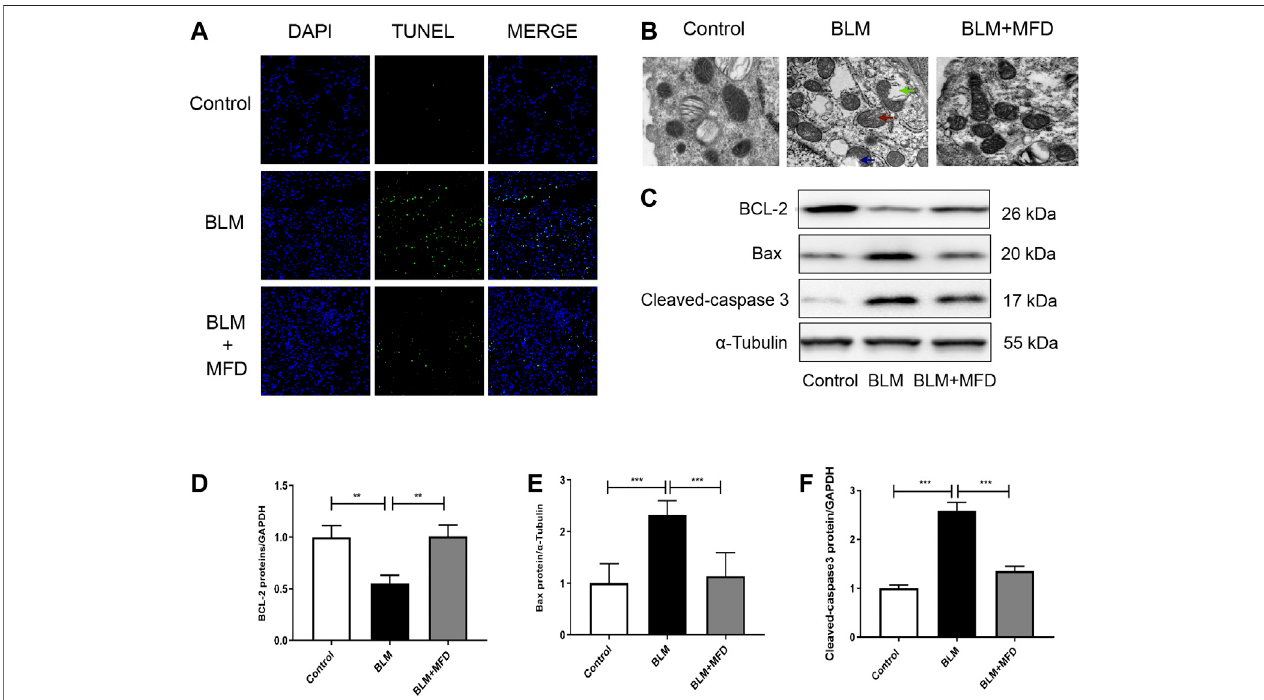
FIGURE 5 | Mefunidone attenuated bleomycin-induced mitochondrial injury and cell apoptosis (A) : Representative images of TUNEL assay of lung tissues from different groups. DAPI stained the nuclei, and TUNEL stained the apoptotic cells. The magni fi cation was × 200 (B) : Representative images of mitochondrial morphology from different groups captured by transmission electron microscope. The treatment of bleomycin (BLM) induced mitochondrial vacuolization (see the blue arrow), swelling (see the red arrow) and rupture of outer membrane (see the green arrow). The magni fi cation was × 20,000 (C – F) : Western blotting (C) and quantitative analysisofBcl-2 (D) ,Bax (E) andCleaved-caspase3 (F) inlungtissuesfromdifferentgroups.Alldatawerepresentedasmean ± SD.ANOVAwasusedforcomparisonin (D-F) . * p < 0.05; ** p < 0.01; *** p <